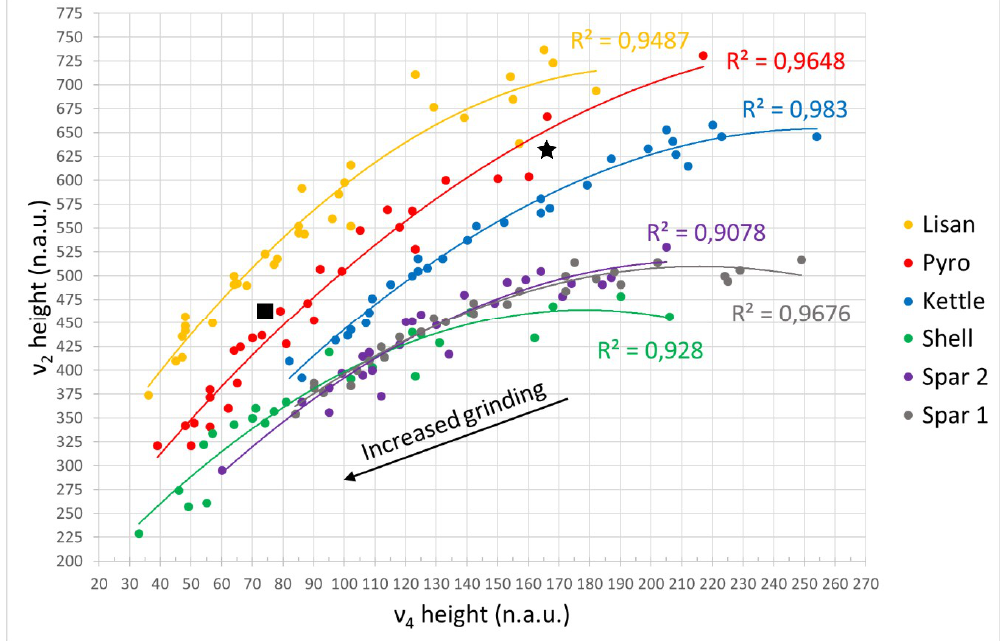
Figure 3. Aragonite grinding curves plot (n.a.u.: normalized absorbance units). Star: pyrogenic aragonite from Tell es-Safi/Gath. Square: pyrogenic aragonite from Megiddo.